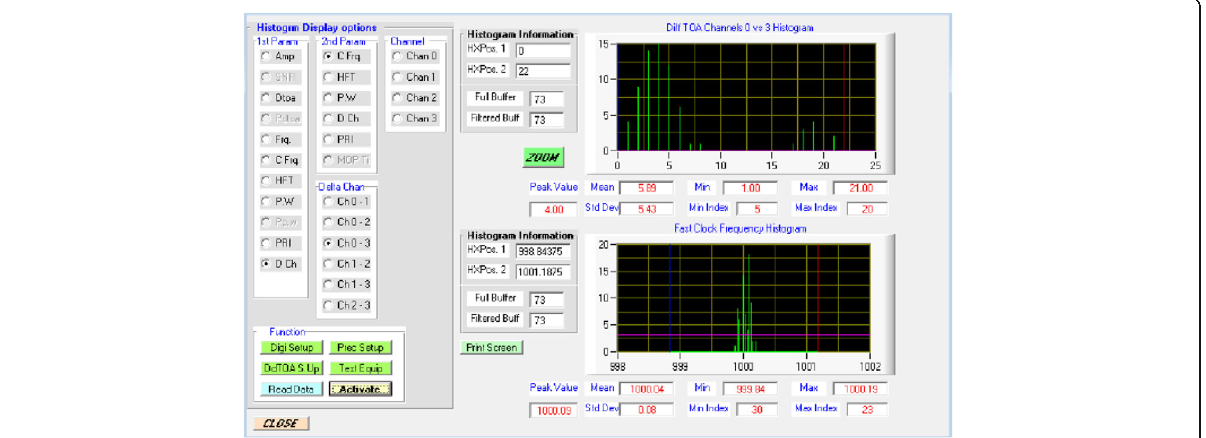
Fig. 3 Graphical user interface (frequency, pulse width (PW), pulse repetition interval (PRI), and